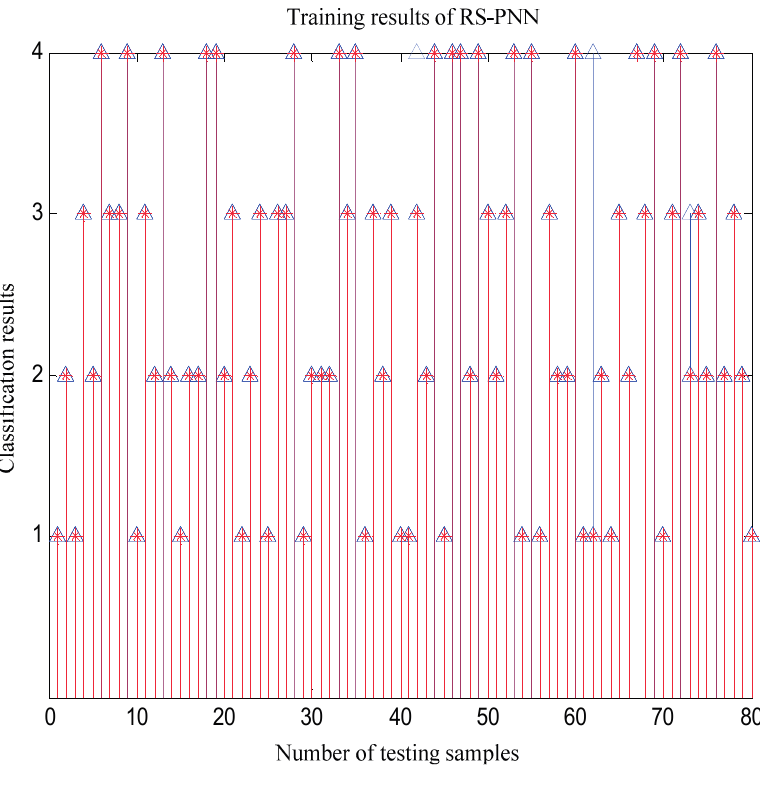
Figure 13. Classification results of RS-PNN under testing samples.